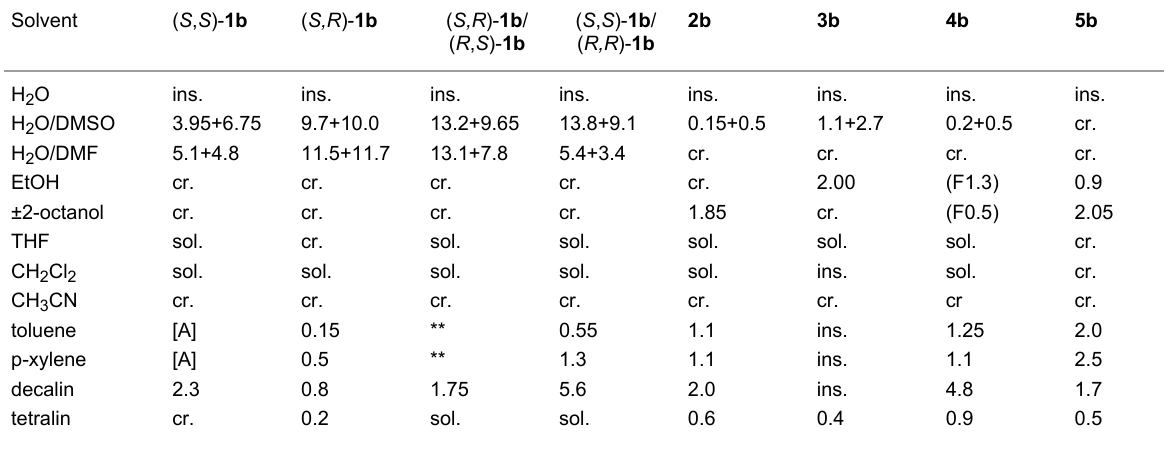
Table 2: Gelator effectiveness (G eff , mL) of bis(dipeptide)oxalamide dimethyl esters 1b – 5b in gelation of various solvents and solvent mixtures (sol.: soluble; ins.: insoluble; cr.: crystallization; [A] gel/sol mixture; (F): cotton-like fiber aggregates; ** the mixture of crystals and gel.). Solvent ( S , S )- 1b